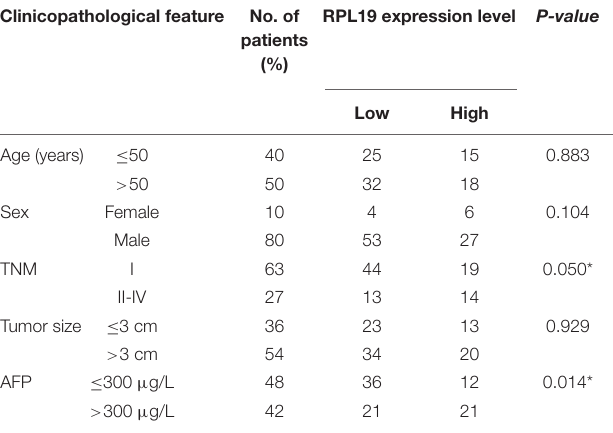
TABLE 3 | Relationship between RPL19 expression and the clinicopathological features of hepatocellular carcinoma patients. Clinicopathological feature No. of patients